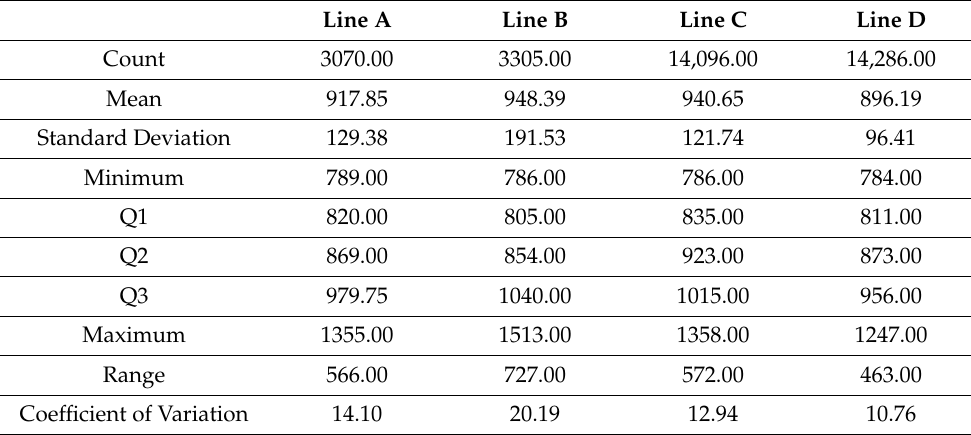
Table 4. Descriptive statistics of cycle time (in seconds) without outliers, per line.